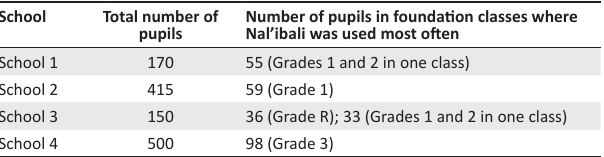
TABLE 2: Demographics of